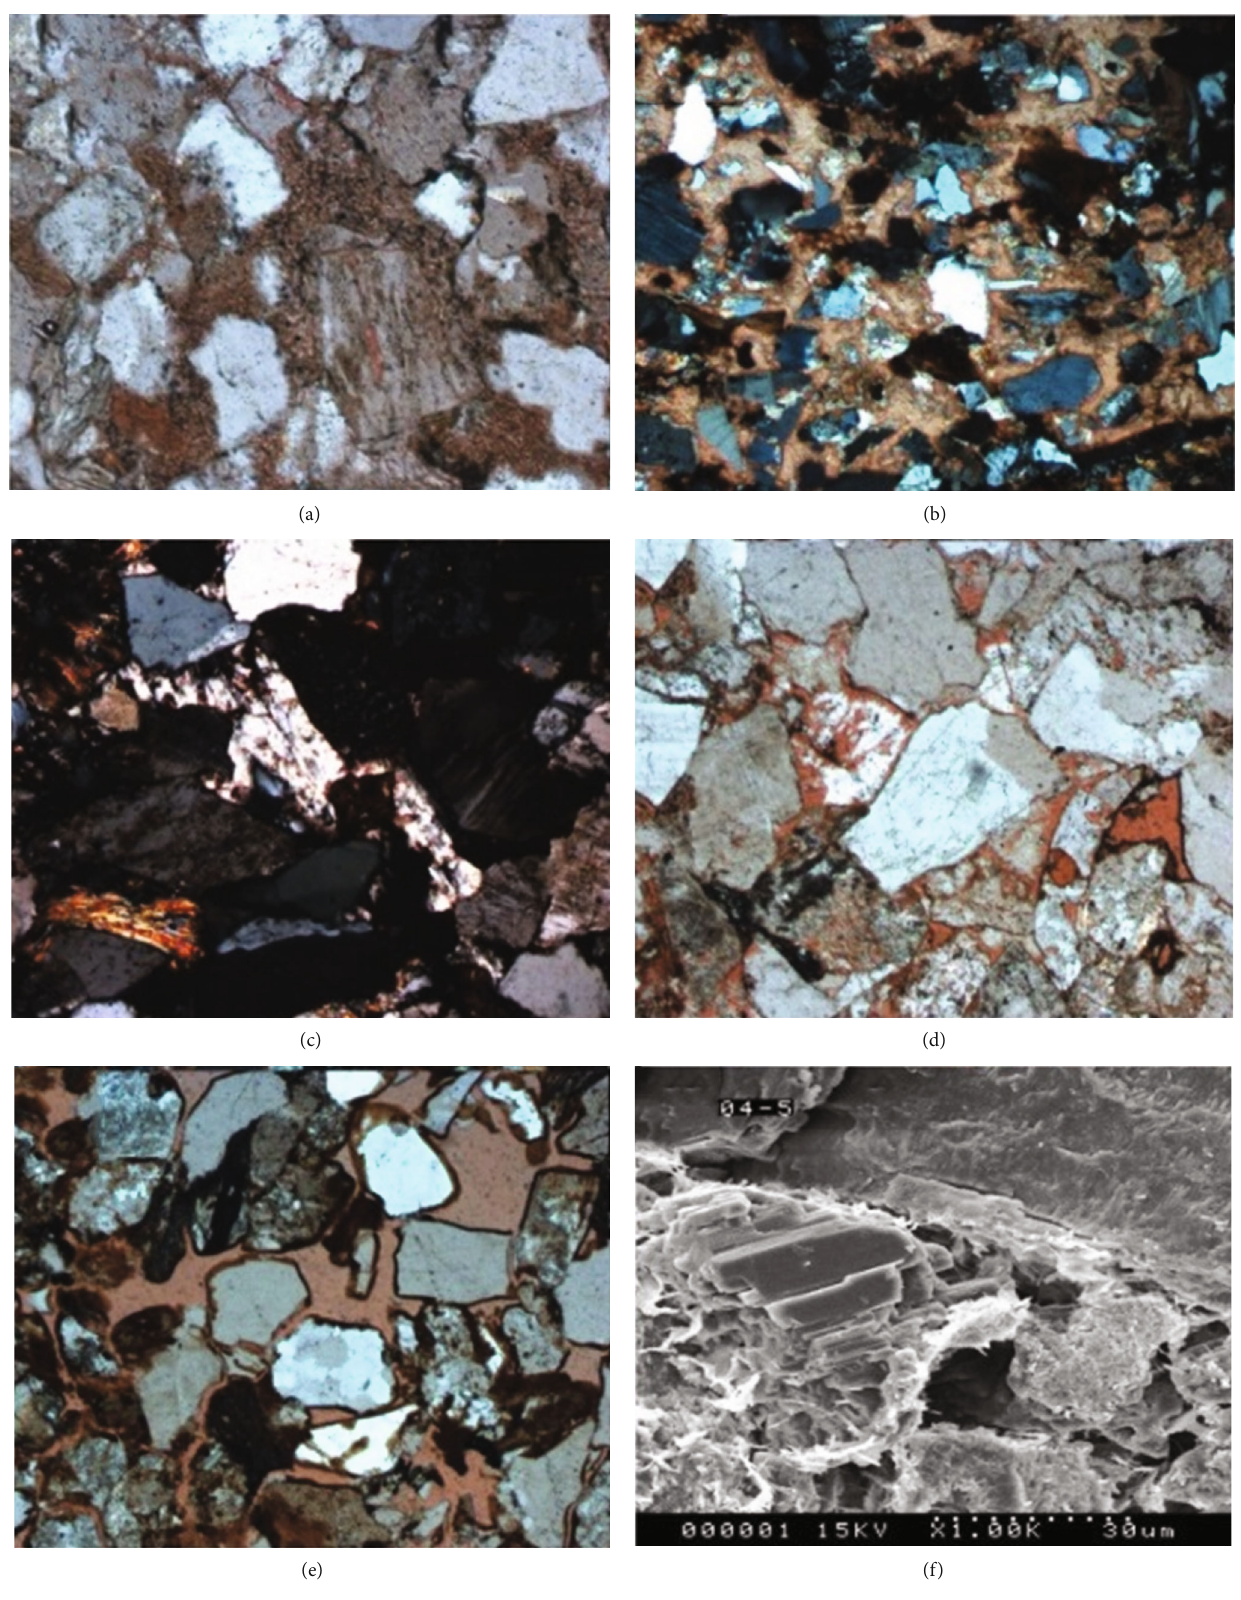
Figure 6: Cement and pore characteristics. (a) Kaolinite cements, D 1184 well, 20(-), C8. (b) Ferric calcite cement, 10(+), D 1729 well. (c) Turbidite cementation, 10(+), C 3604 well, C8. (d) Ingranular and intergranular, (-) 10, 81, D 4225 well. (e) Intergranular solution hole, 10(-), 4267 well, C8. (f) Intergranular solution pore of zeolite, 3604 well,